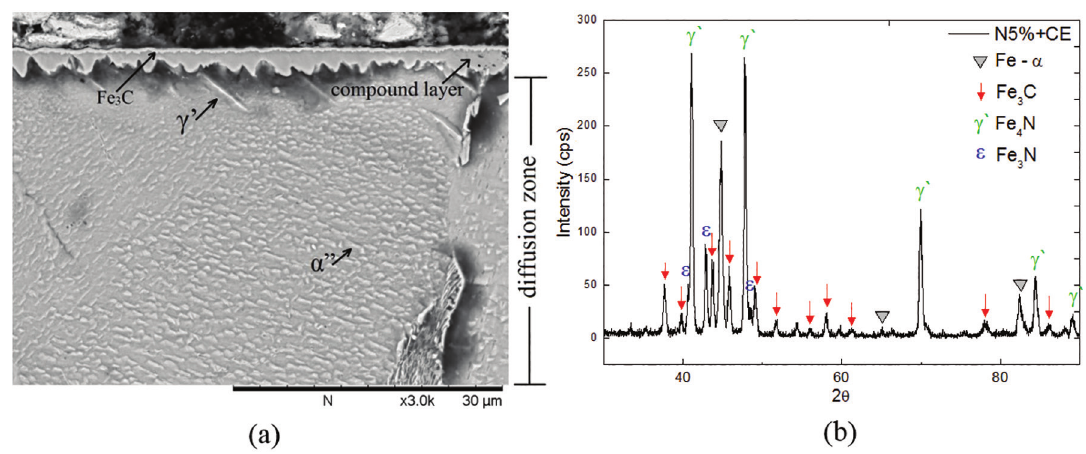
Figure 6: Sample N5%+CE: (a) scanning electron microscopy and (b)